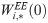
Analysis of changes in input weight vectors over training.(A) Euclidean distance of all 300 weight vectors from the initial weight Wi,*EE(0) across training in Experiment 1 [24] projected into the space of the first three PCs of all weight vectors. The blue part of each curves corresponds to training on sequence S1 and the red part corresponds to training on sequence S2. (B) Change in angle of the weights versus the total distance of the weights to the initial weight across training in Experiment 1. The angle was computed through the dot product in the full 300 dimensional space of weights. The total distance of weights was computed as the Euclidean distance of the weight vectors Wi,*EE(t) to the initial weight vector Wi,*EE(0). The blue data points correspond to the respective values after the first 1600 training steps and the red data points correspond to the weights after the last training step. The black data points correspond to the changes in angle versus distance in weights across training after switching from sequence S1 to sequence S2. Panels (C,D) as Panel (A, B) but for the data of Experiment 2 [25].